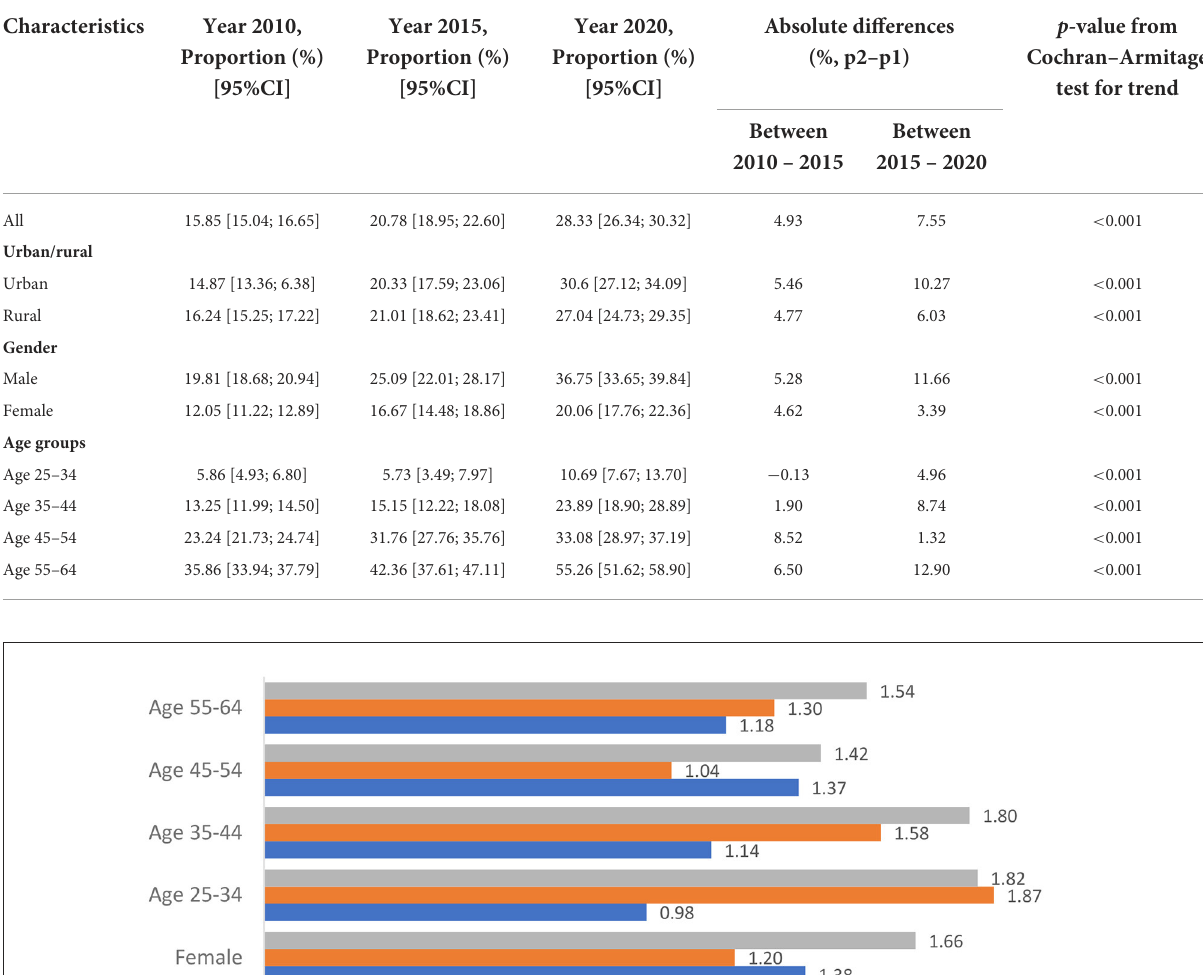
TABLE 1 Absolute changes in the prevalence of raised blood pressure among the population aged 25–64 years over time. Characteristics